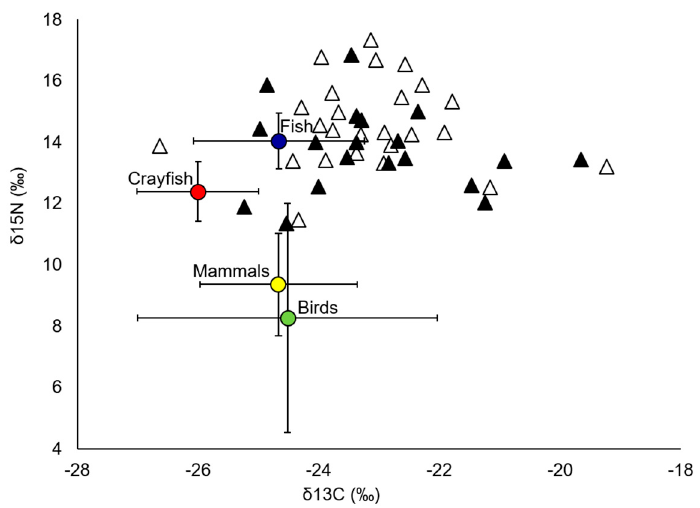
Figure 2. Scatterplot of the dispersion of the δ 15 N and δ 13 C isotopic signatures of hair samples from the European mink in the pre-invasion (open triangles) and post-invasion (filled triangles) stages. Prey isotopic signatures are shown as means (±SD).